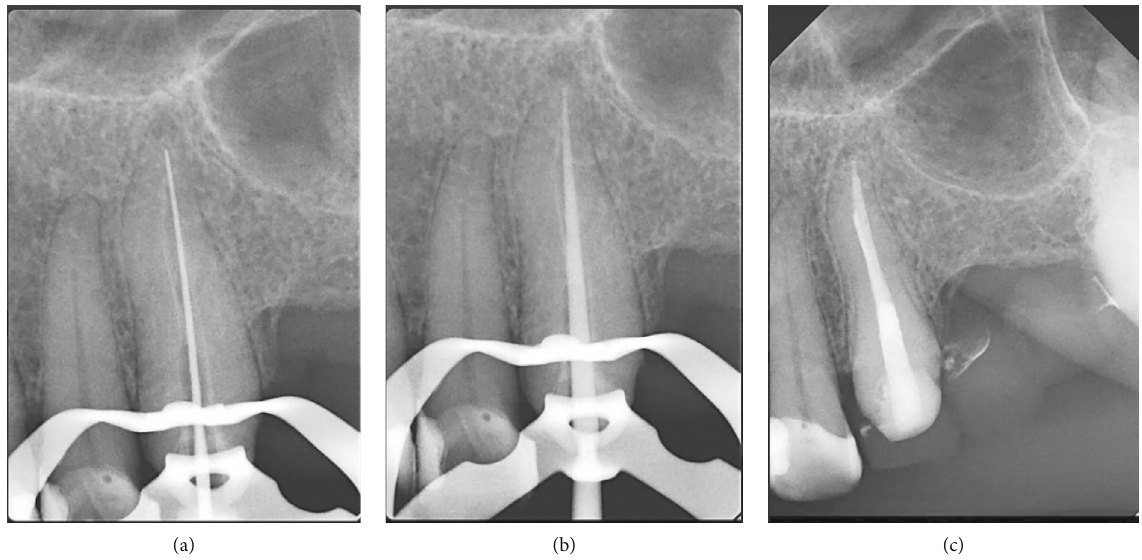
Figure 5: (a) Working length determination radiograph. (b) Master gutta-percha cone radiograph. (c) Final